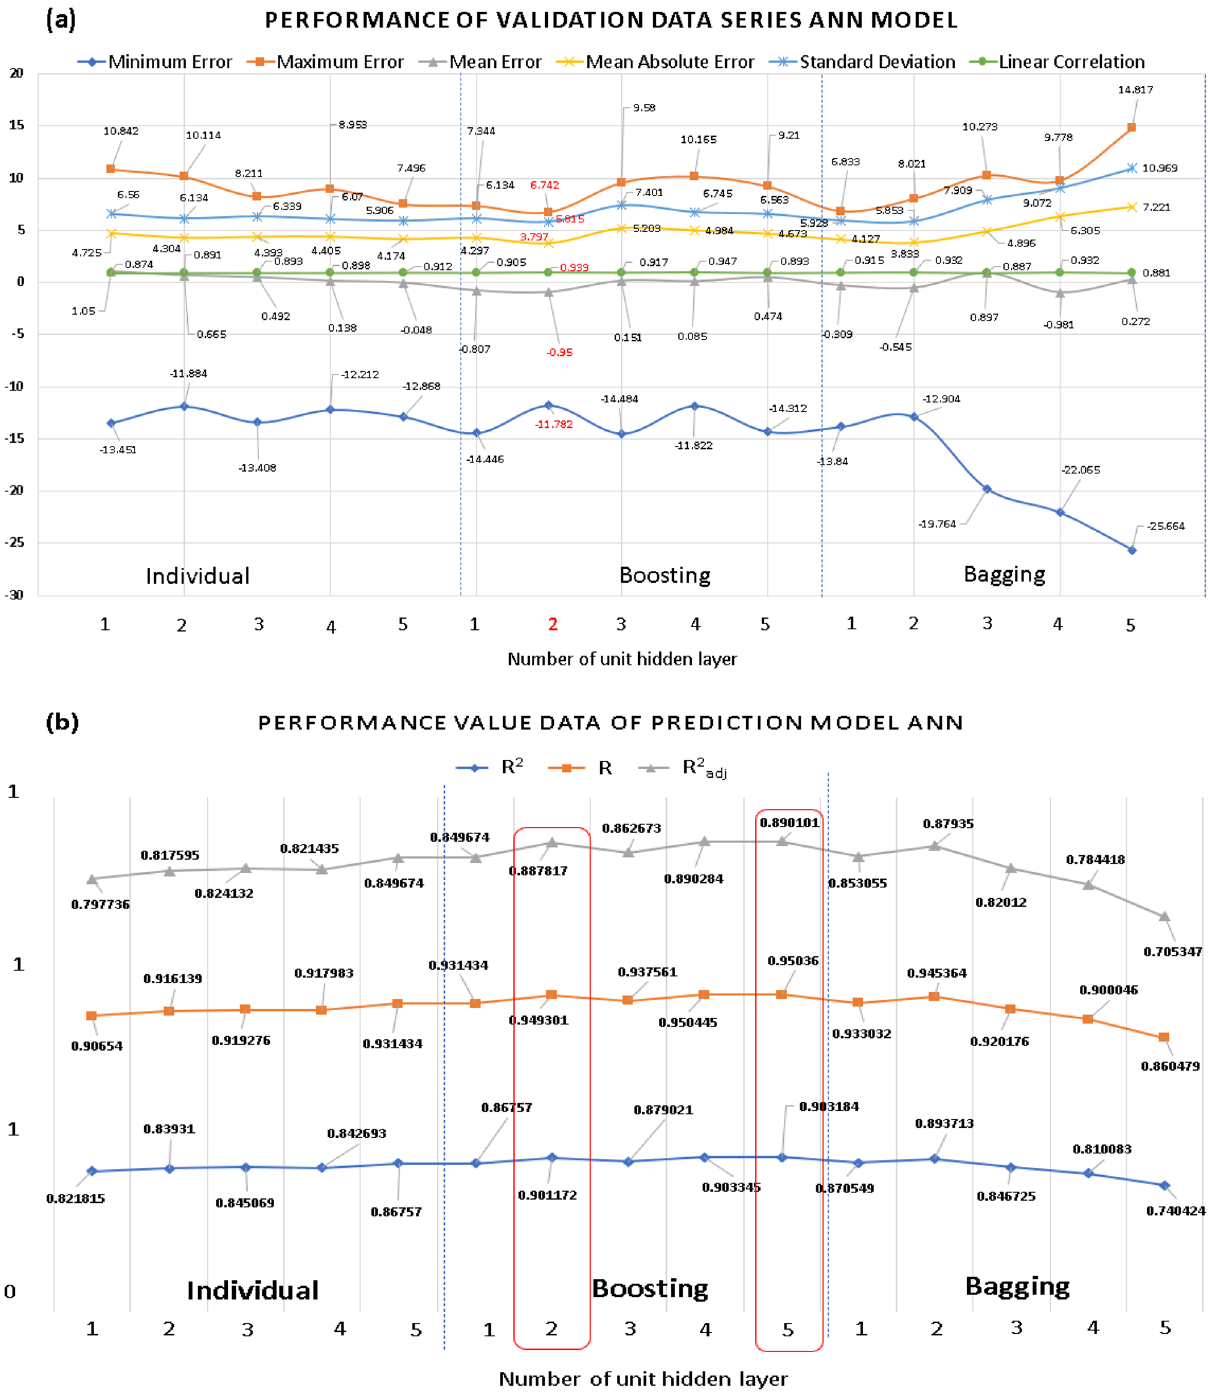
Figure 8. Performance evaluation and comparison ( a ) validation data ( b ) prediction model the single, boosting and bagging models of ANN for modeling i corr of carbon steel in soil with variations in the unit of hidden